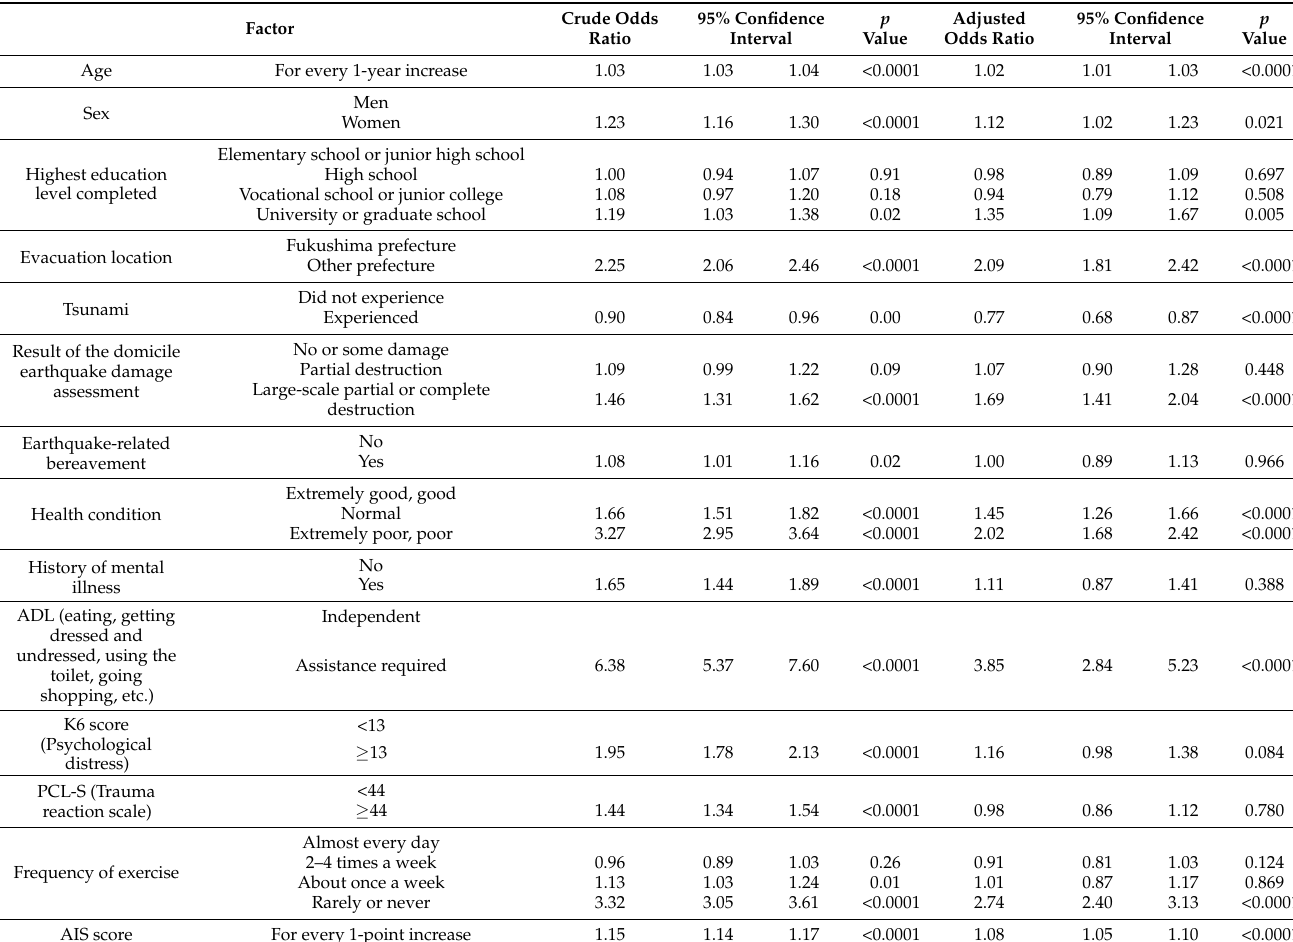
Table 2. Results of the logistic regression analysis with social nonparticipation as the dependent variable.